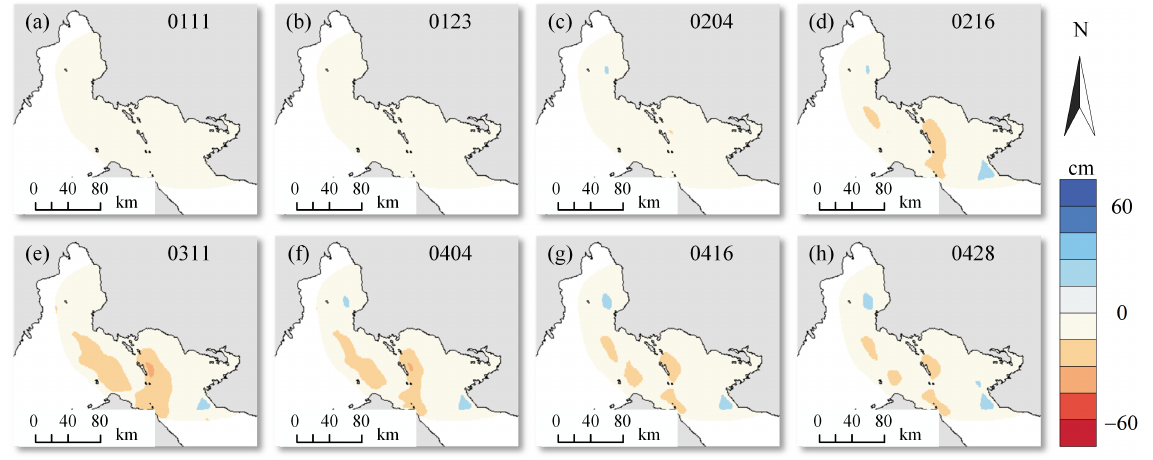
Figure A5. Time-series LOS deformation retrieved from the 2020 ascending images: the top-right number of subfigures ( a – h ) represents the corresponding SAR images acquisition dates.